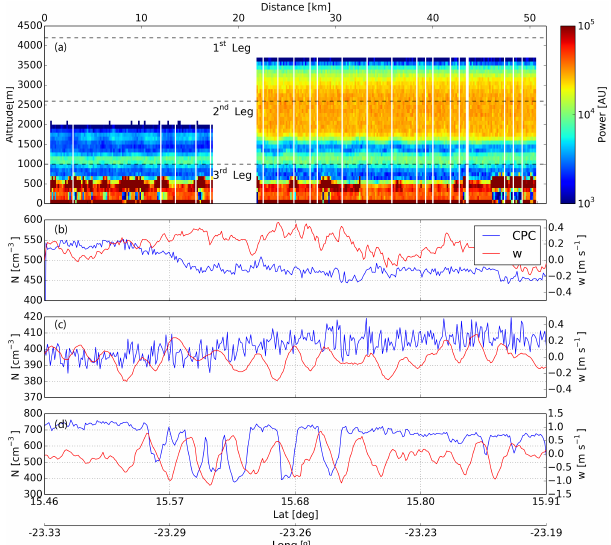
Figure 9. (a) Retrieved range corrected backscatter power by the DWL as a function of the latitude and longitude from legs 1 and 2, together with the flight levels corresponding to the legs 1, 2 and 3 (dashed lines). (b, c, d) In situ CPC measurements (blue line) cor- responding to the legs 1, 2 and 3 together with the in situ measured vertical wind (red line).